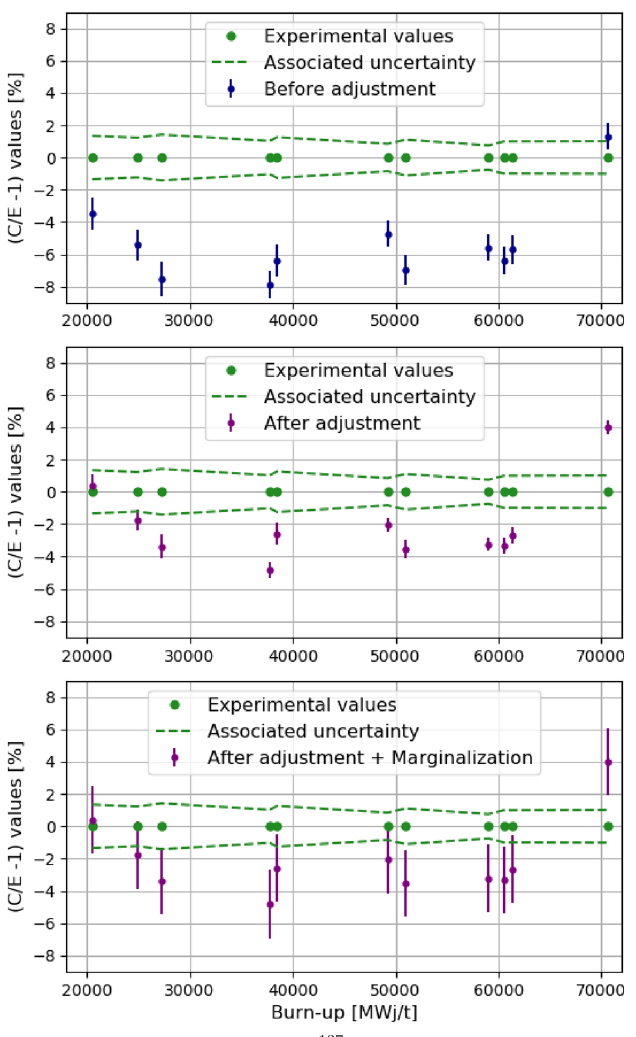
Fig. 3. (C/E)-1 values of the 137 Cs concentration calculation before fi t (top), after fi t (middle), and after fi t+ marginalization